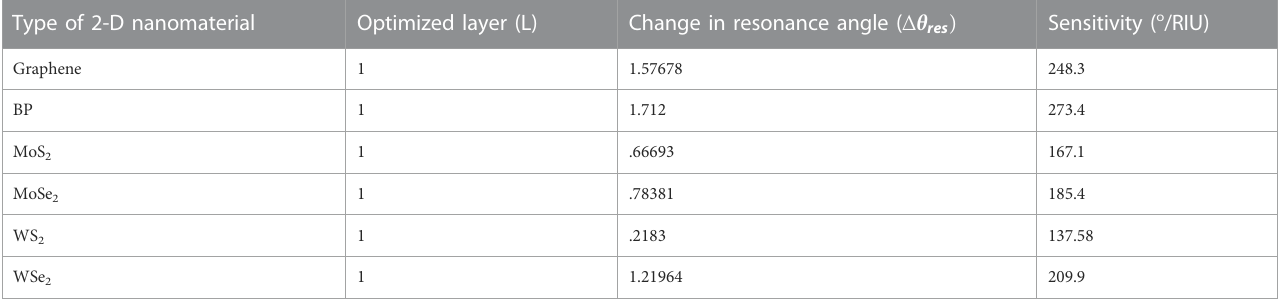
TABLE 7 Optimized layer, change in resonance angle, and calculated Sensitivity for the Structure-II, Au/Si with 2-D nanomaterials (Graphene/BP/MoS 2 /MoSe 2 /WS 2 / WSe 2